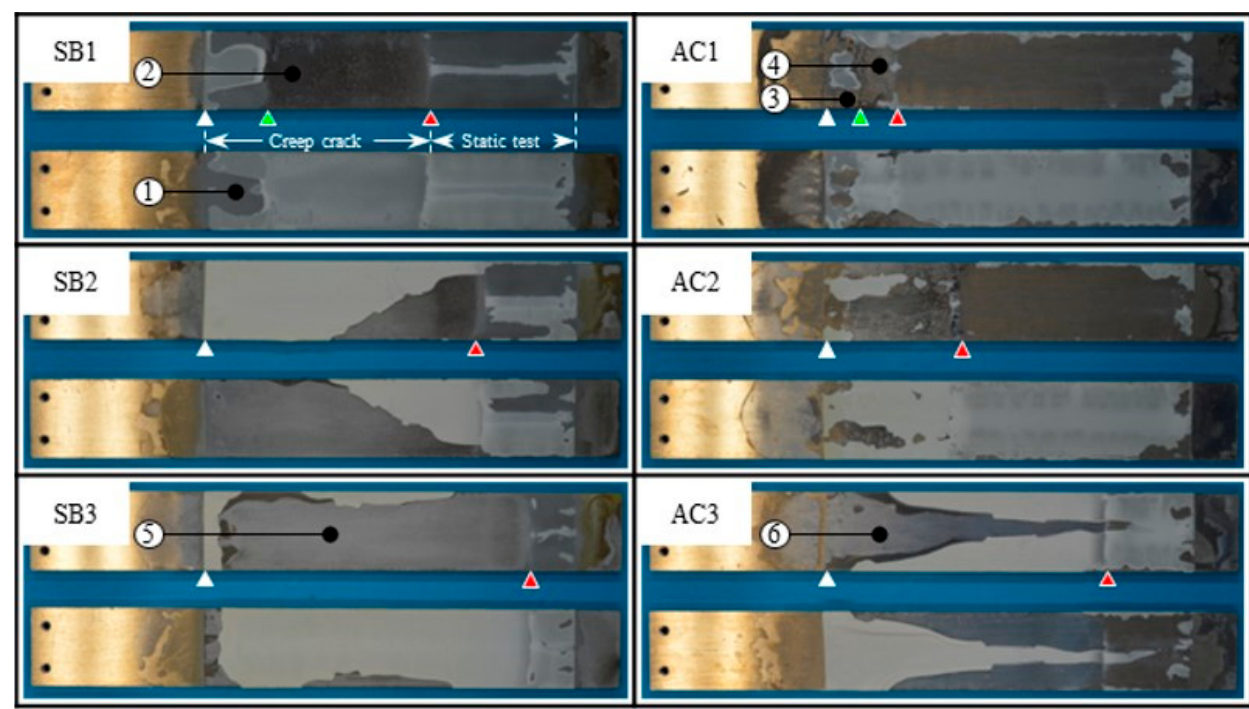
Figure 11. The macroscopic image of the fractured surfaces of the specimens after the spring-loaded DCB tests. White triangles: initial crack positions; light-green triangles: failure mode changing points; red triangles: crack positions after creep immersion tests. Numbered locations are magnified using a microscope in Figure 12.